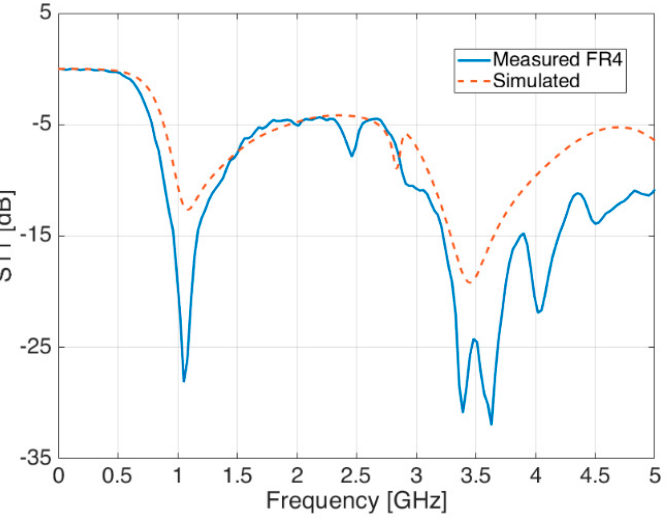
Figure 24. Normalized gain pattern of the FR-4 prototype at 3.5 GHz, ( a ) XY plane, ( b ) XZ plane, and ( c ) YZ plane—Simulated (blue dashed line) and Measured (red line) data in dB.